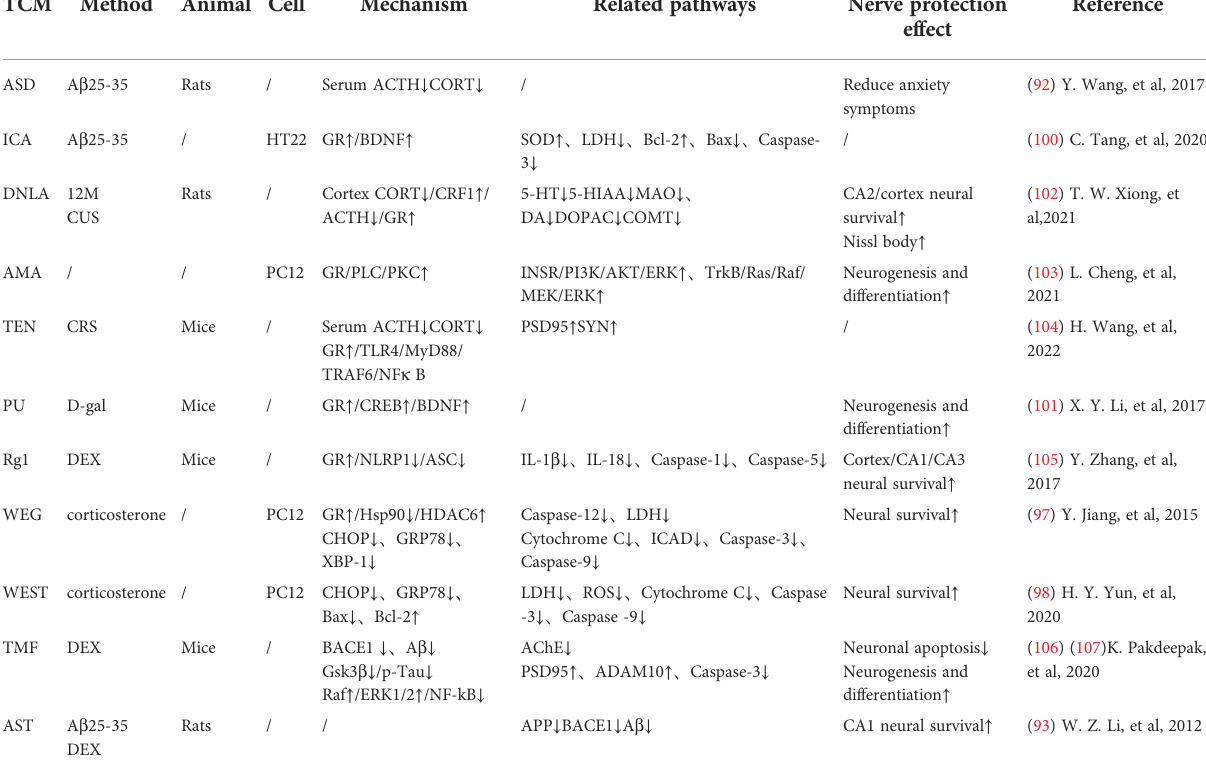
TABLE 1 TCM treats AD by regulating the mechanism related to HPA